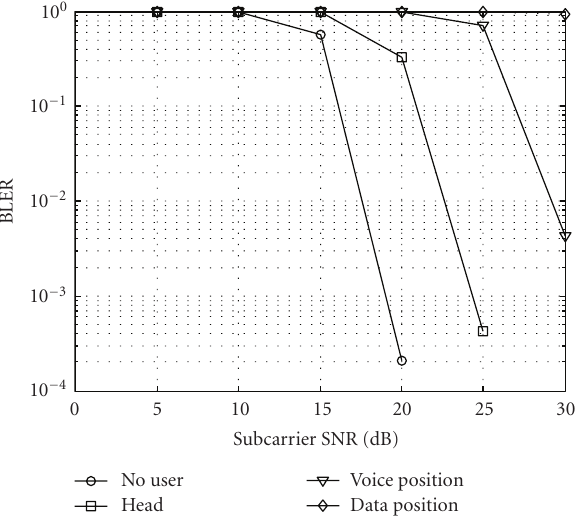
Figure 13: BLER in di ff erent usage scenarios for a 2 × 2 MIMO system with transmit